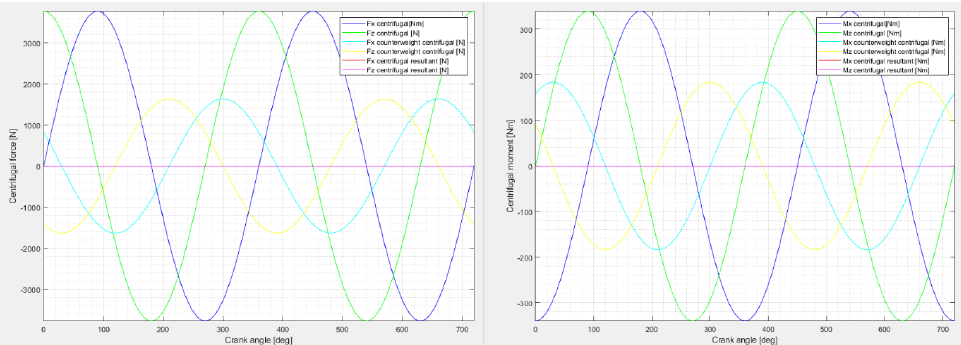
Figure 12. Centrifugal forces ( left ) and moments ( right ) for a 3 cylinder in-line engine.